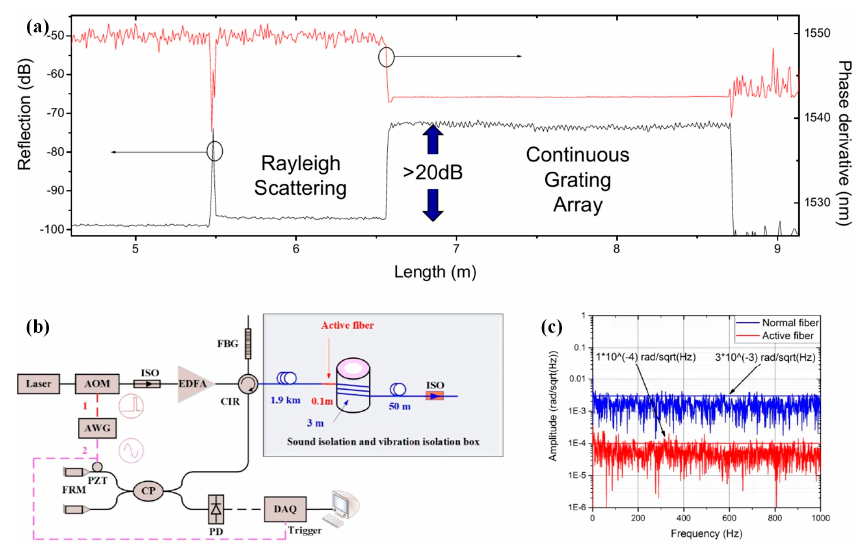
Figure 5. Typical scheme of continuous scattering-enhanced optical fiber [33,36]: ( a ) the backscattering signal distribution of a typical continuous scattering-enhanced fiber; ( b ) scheme of improved Rayleigh scattering achieved by changing the fiber doping; ( c ) scattering spectrum of high Rayleigh scattering fiber.